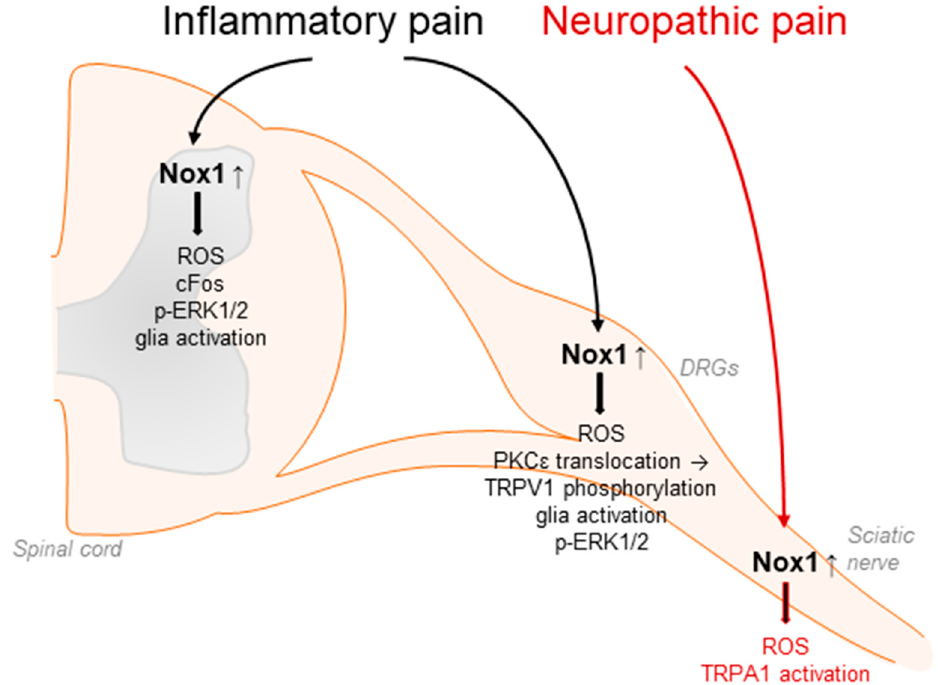
Figure 2. Nox1 affects inflammatory pain processing by redox regulation and translocation of PKC ε to the plasma membrane. This subsequently modulates TRPV1-mediated signaling, glia activation, cFos upregulation, and phosphorylation of ERK1/2 in DRGs and/or in the spinal cord. In addition, Nox1 expressed in Schwann cells affects neuropathic pain signaling in response to peripheral nerve injury through activation of TRPA1 in sensory neurons.